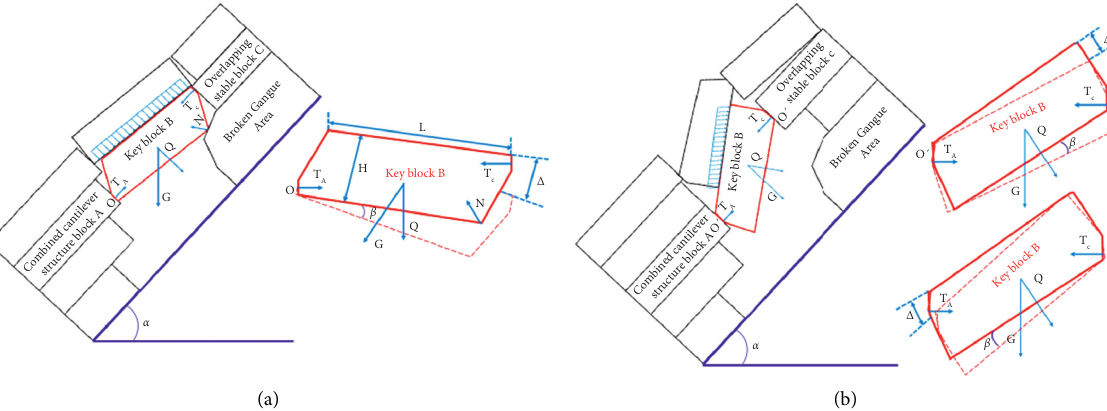
Figure 2: Force analysis of key block B of overlying strata in high-inclined coal seam stope. (a) The key block B is unstable around point O , forming an anti-trend to accumulate structure. (b) The key block B is unstable around O ′ point, forming a tendency to accumulate structure.